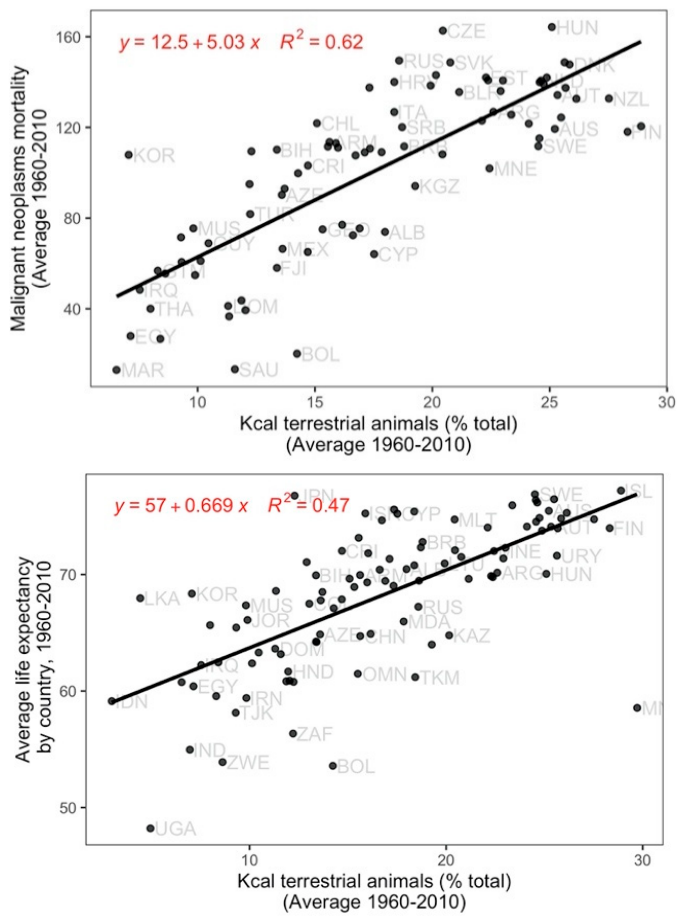
Figure 3. Relationship of the mortality (per 100,000 population) of malignant neoplasms (total number of cancers) and the average life expectancy per country from 1960 to 2010 with country annual mean percentage of total Kcal from terrestrial animal sources. p <